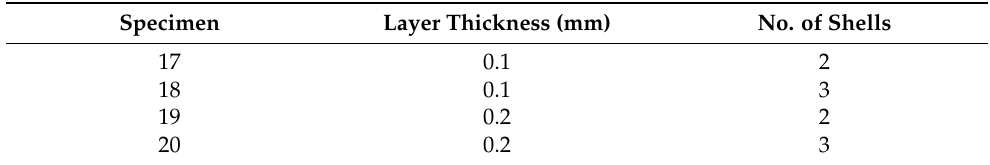
Table 3. 3DP process parameters in experiment